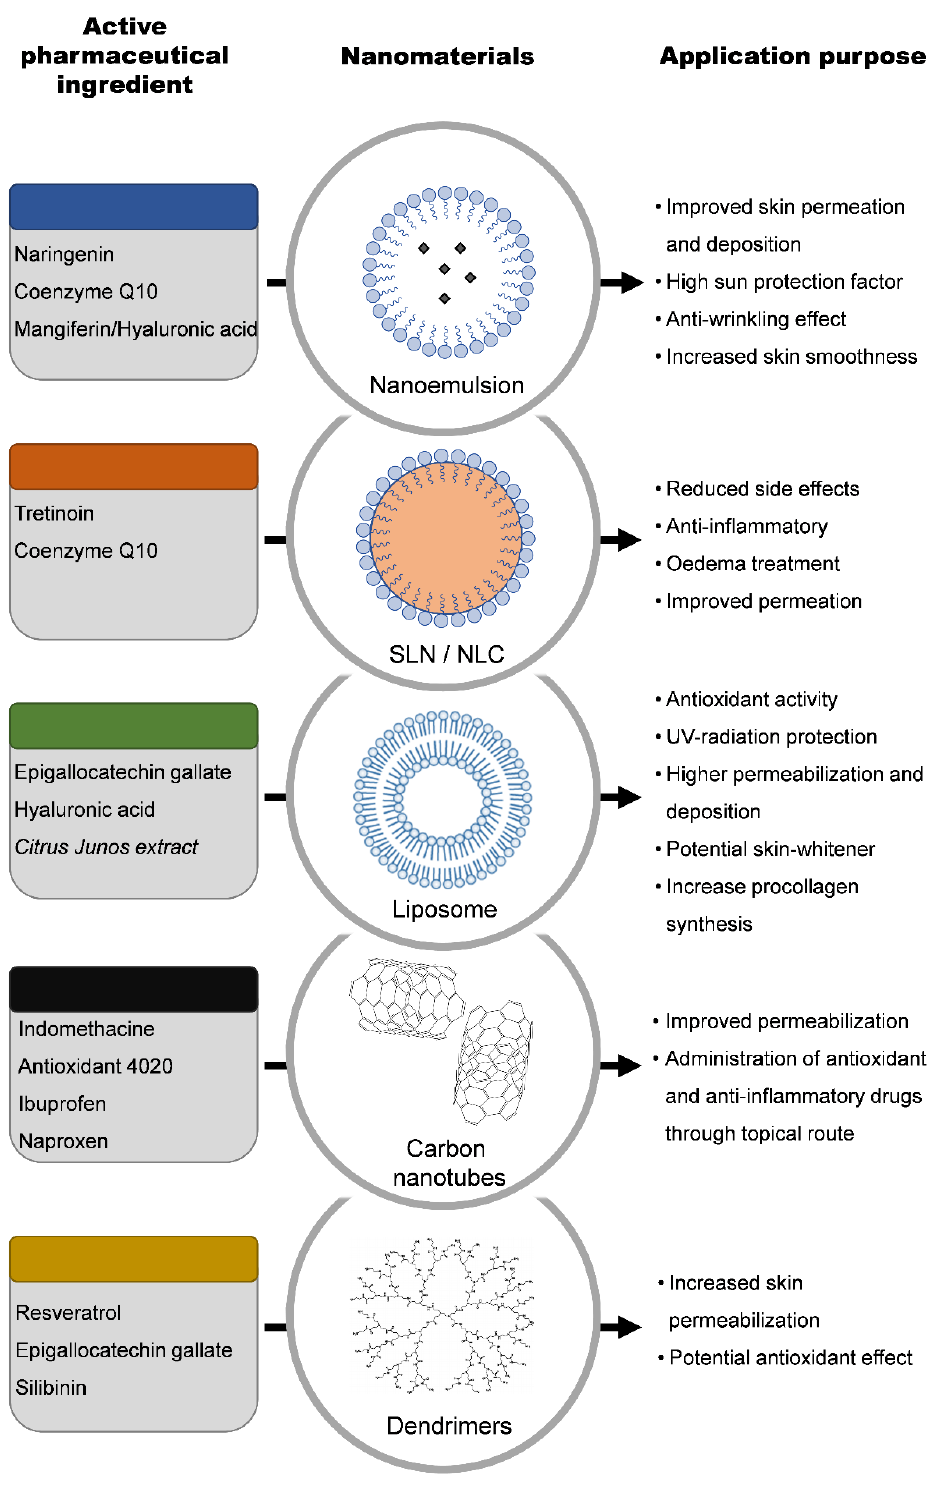
Figure 2. Examples of nanomaterials used for the encapsulation of several active pharmaceutical ingredients and their application